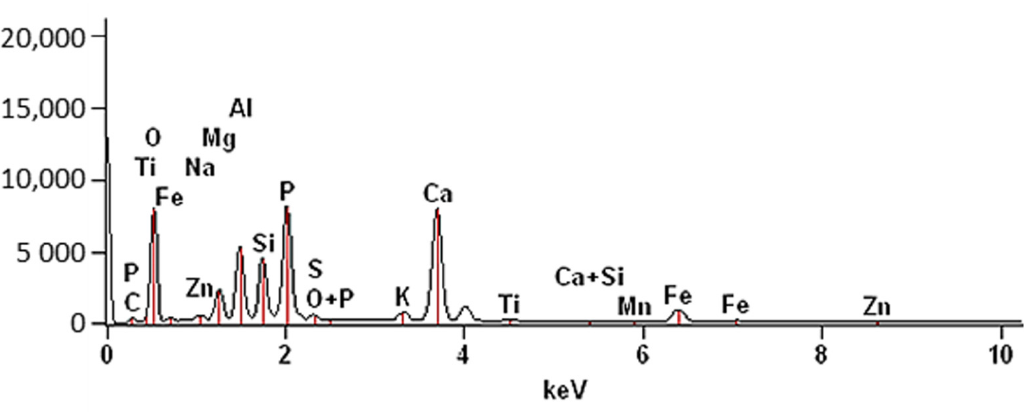
Figure 4. EDS spectrum of SS-FA (magn. x200). Table 1. Elemental composition of SS-FA (EDS microanalyzer) and comparison with the literature.